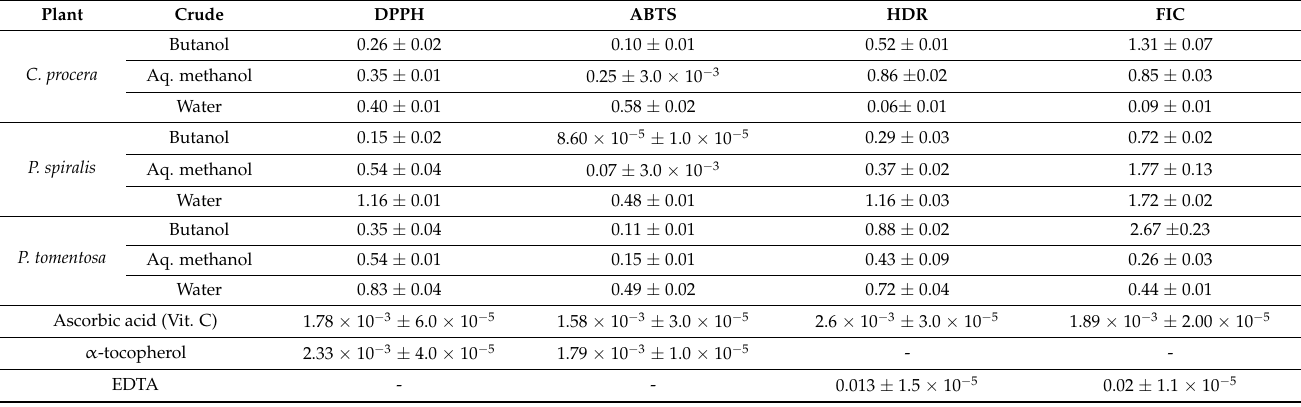
Table 4. IC 50 (mg/mL) values of crude extracts from C. procera , P. spiralis , and P. tomentosa and standards using the DPPH, ABTS, HDR, and FIC